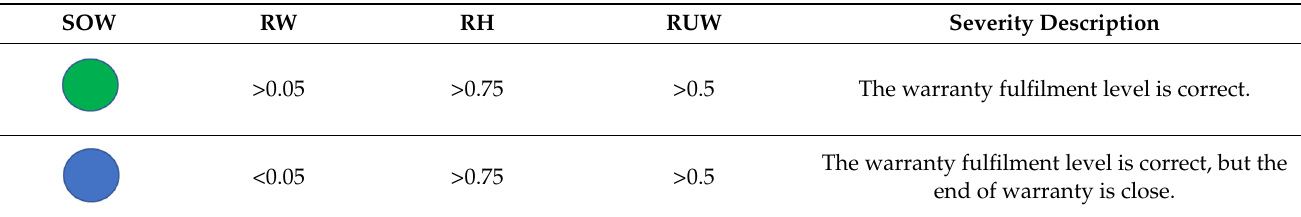
Table 1. SOW rule-based logic.